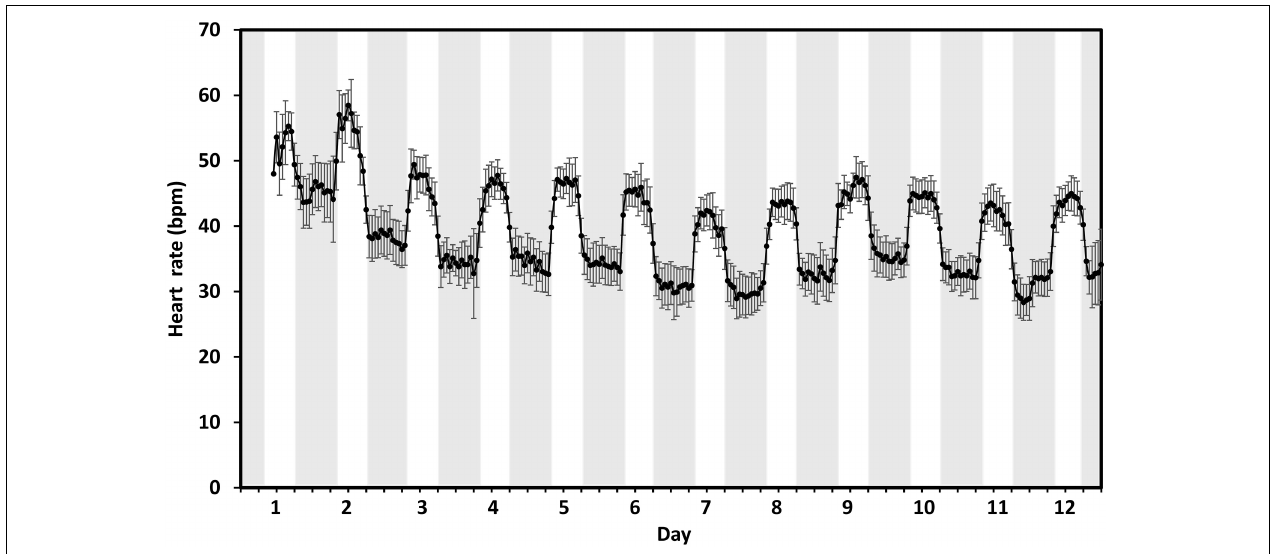
FIGURE 2 | Post tagging recovery. The hourly mean heart rate measured in beats per min (bpm) of 17 fish tagged with DST centi-HRT tags between 11:00 and 14:00 (day 1) in early February 2020. Error bars represent ± 95% CI. Gray bands indicate approximate civil hours of darkness.